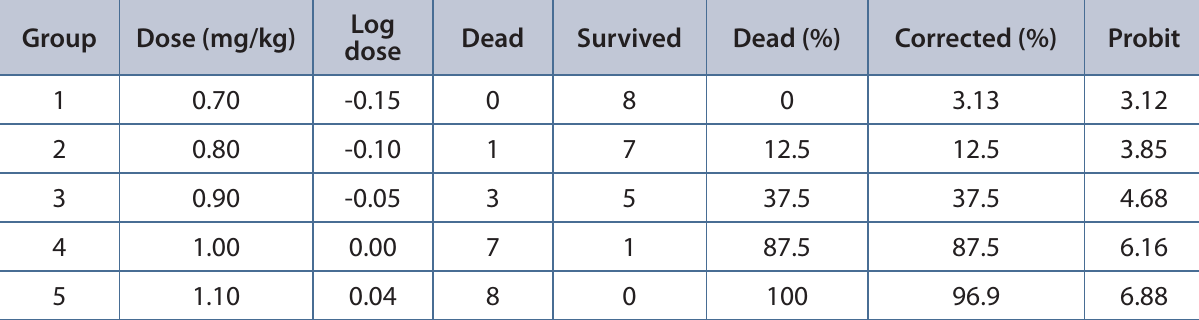
Figure 1. The HPLC spectrum obtained through fractionation of the crude extract using Sephadex LH-20 packed column (dimension – 30.0 cm x 1.0 cm ID). The peaks were detected at 344 nm. Table 2. Results of mortality data in mice envenomed with Naja kaouthia venom, obtained according to Miller and Tainter method